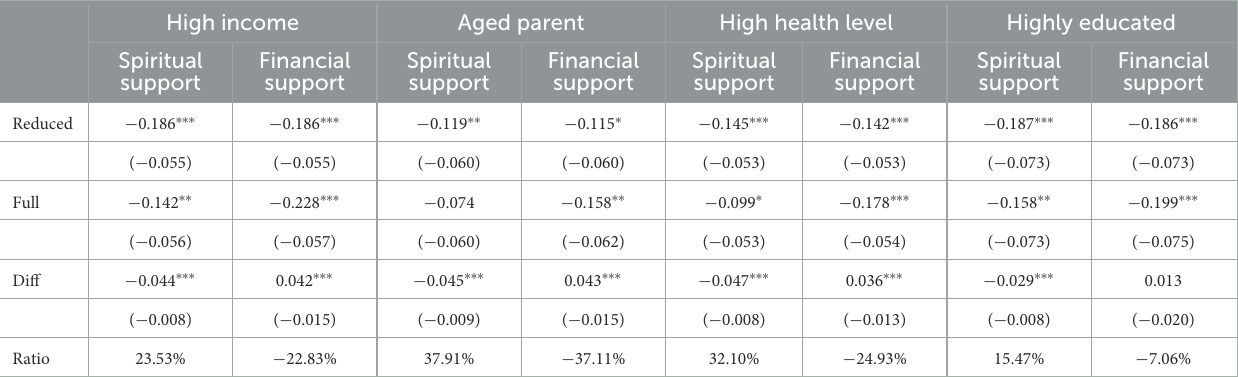
TABLE 7 Sub-sample KHB test results.